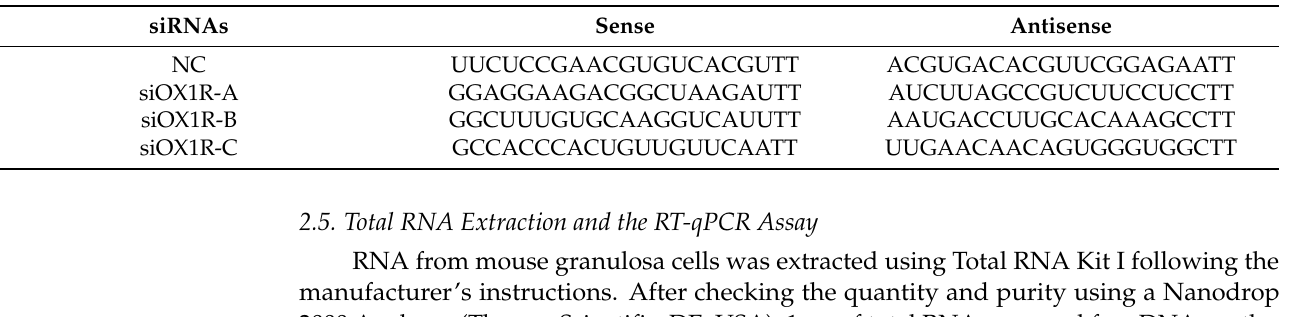
Table 1. The sequences of NC and siRNAs used in this